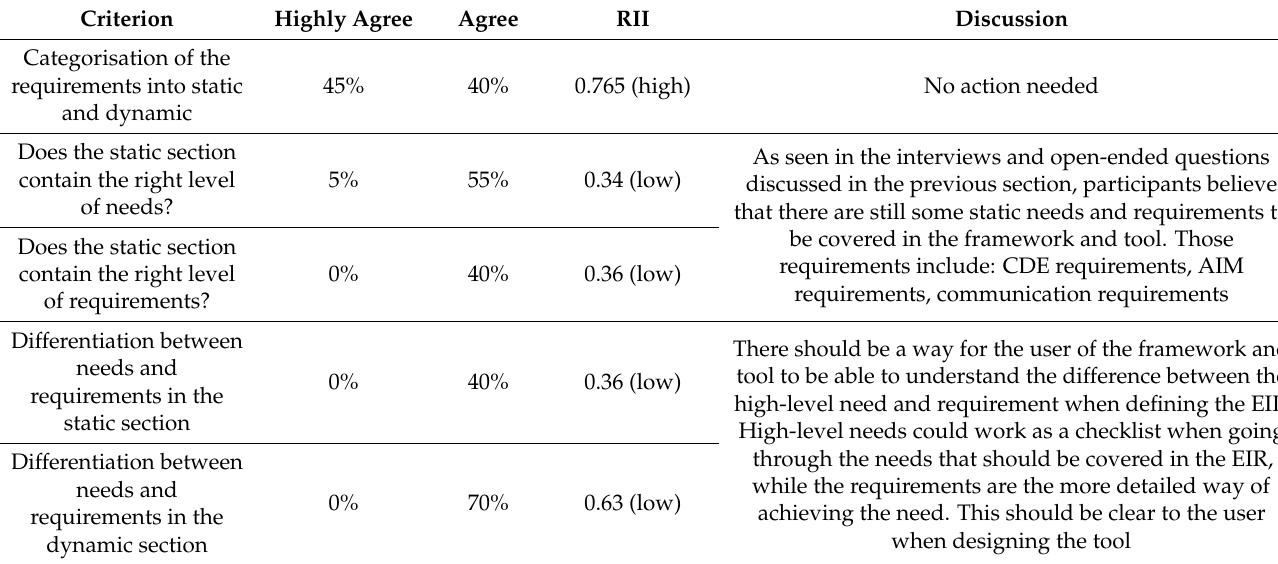
Table 9. Weakest to Strongest Criterion and Ways to